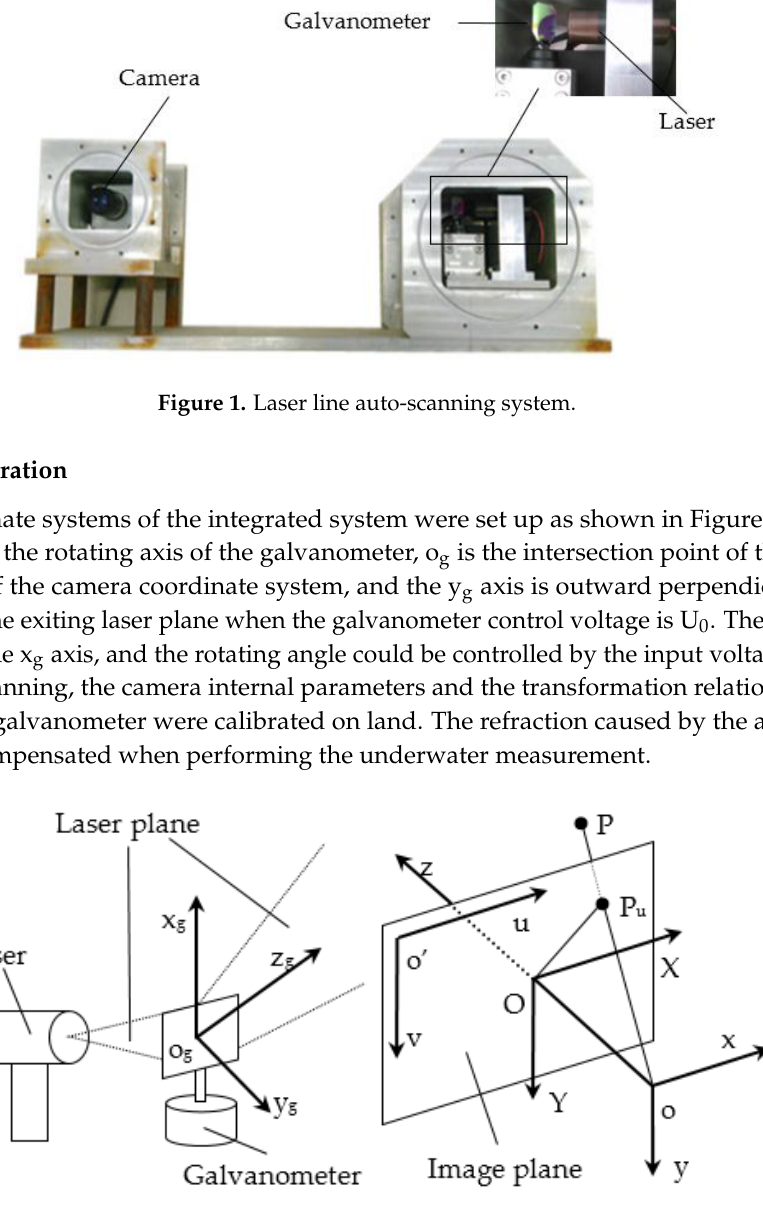
Figure 1. Laser line auto-scanning system.